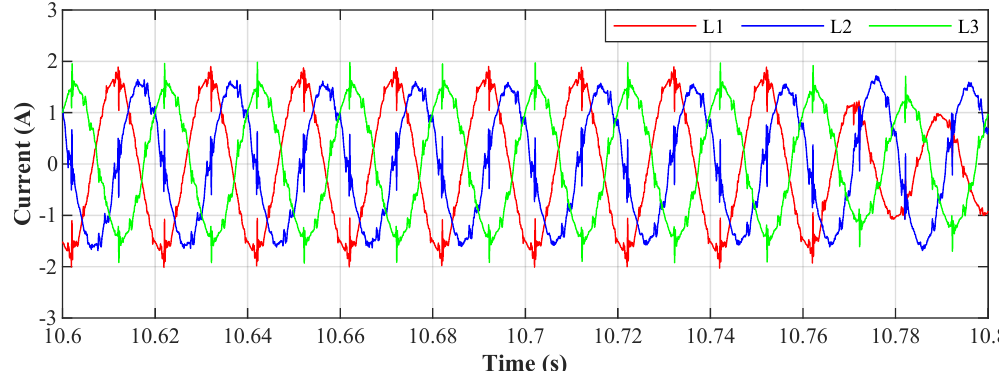
Figure 17. Switched on test polygon; current waveforms after applying the RLS